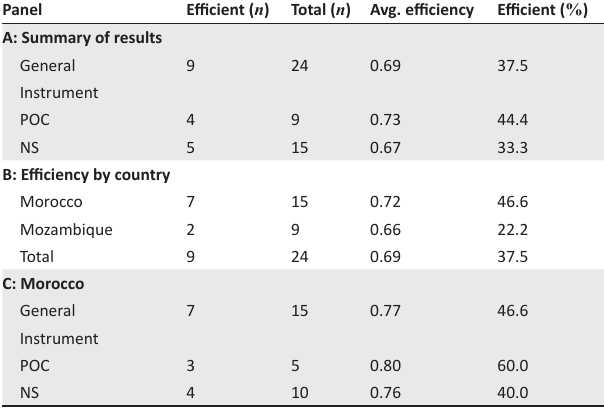
TABLE 8: Instrument efficiency: General model (Inputs: purchases and other services).